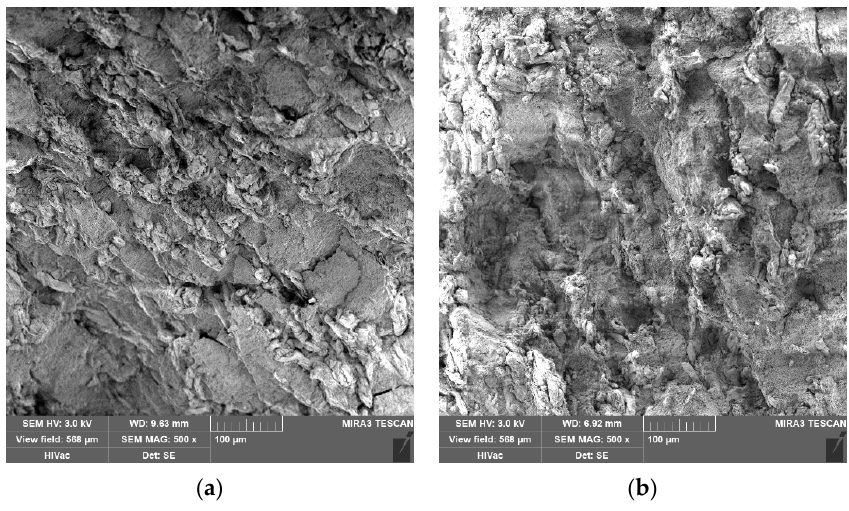
Figure 5. Images of PrunusP_W_HA_180 min ( a ) and PrunusP_W_MW_3 min ( b